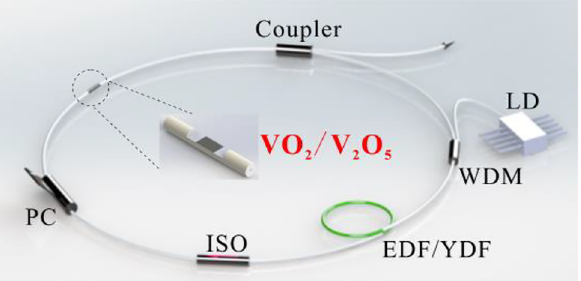
Figure 5: Experimental setup of the 1 μ m and 1.5 μ m mode-locked fi ber laser.